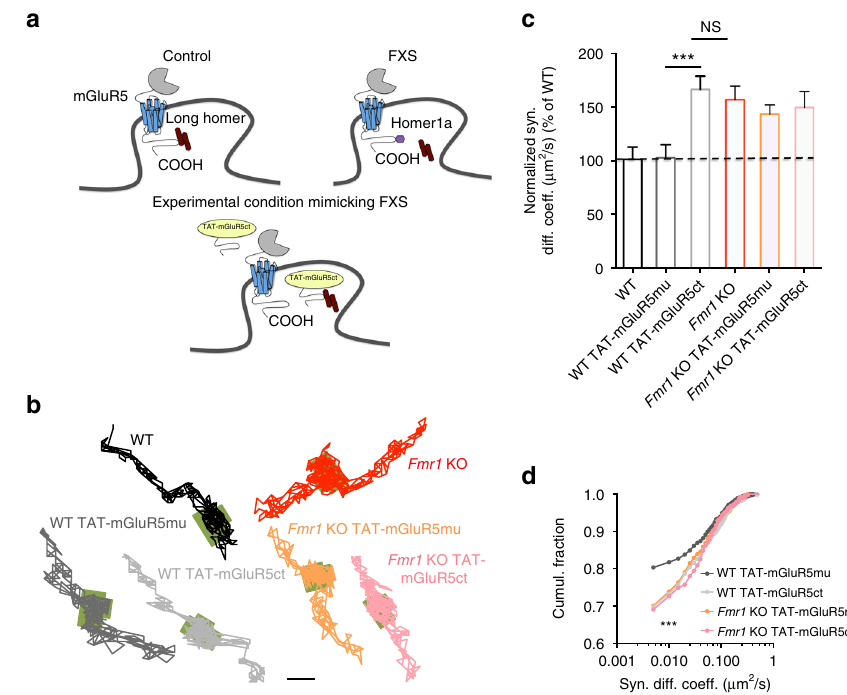
Fig. 2 Disruption of the link between mGluR5 and Homer in WT neurons mimics the Fmr1 KO phenotype. ( a ) Schematic illustration of the effect of the cell- permeable TAT-mGluR5ct peptide. This peptide disrupts the mGluR5/Homer link, mimicking the situation in Fmr1 KO neurons. ( b ) Representative trajectories of single surface mGluR5-QD in WT and Fmr1 KO neurons treated with TAT-mGluR5ct and its mutated TAT-mGluR5mu control peptide (both peptides 5 µ M, 1 h). The synaptic sites are represented by the green areas. Scale bar = 1 μ m. ( c ) Normalized cumulative distribution of the instantaneous diffusion coef fi cient of mGluR5-QDs in the synaptic area of WT and Fmr1 KO neurons treated with TAT-mGluR5mu and TAT-mGluR5ct. The lateral diffusion rate of mGluR5-QDs in WT neurons treated with TAT-mGluR5ct peptide is comparable to that in Fmr1 KO neurons under basal conditions (WT, 0.016 ± 0.002 µ m 2 /s, n = 636 trajectories from 12 dendritic fi elds of 3 cultures; WT TAT-mGluR5mu, 0.016 ± 0.002 µ m 2 /s, n = 1798 trajectories from 12 dendritic fi elds of 3 cultures; WT TAT-mGluR5ct, 0.026 ± 0.002 µ m 2 /s, n = 1444 trajectories from 19 dendritic fi elds of 3 cultures; Fmr1 KO, 0.025 ± 0.002 µ m 2 /s, n = 797 trajectories from 16 dendritic fi elds of 3 cultures; Fmr1 KO TAT-mGluR5mu, 0.023 ± 0.001 µ m 2 /s, n = 1419 trajectories from 13 dendritic fi elds of 3 cultures; Fmr1 KO TAT-mGluR5ct, 0.024 ± 0.002 µ m 2 /s, n = 489 trajectories from 9 dendritic fi elds of 3 cultures; WT TAT-mGluR5mu vs. WT TAT-mGluR5ct ***P < 0.001 by Kruskal – Wallis test with Dunn ’ s multiple comparison test; WT TAT-mGluR5ct vs. Fmr1 KO P > 0.999 by Kruskal – Wallis test with Dunn ’ s multiple comparison test). ( d ) Cumulative frequency distribution of the instantaneous diffusion coef fi cient of mGluR5-QDs within the synaptic area of WT and Fmr1 KO neurons treated with TAT-mGluR5mu and TAT-mGluR5ct ( ***P < 0.001 by Kolmogorov – Smirnov test. For statistical analysis each condition was separately compared to WT